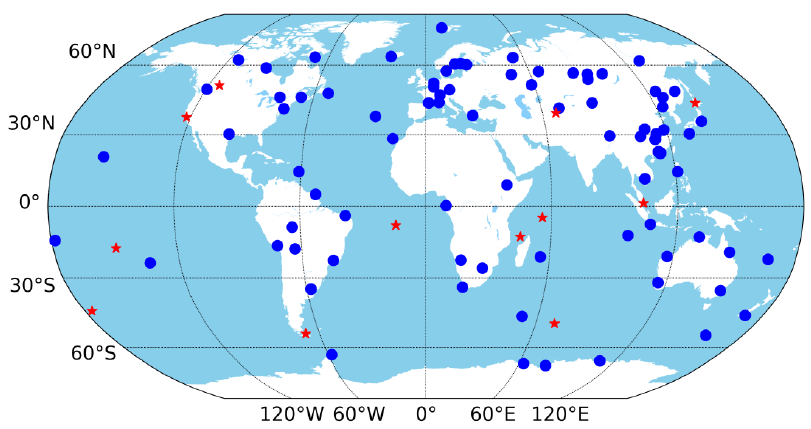
Figure 5. Distribution of stations for the Multi-GNSS (global navigation satellite systems) real-time clock estimation marked by cycles and that for precise point positioning (PPP) test by pentagrams.